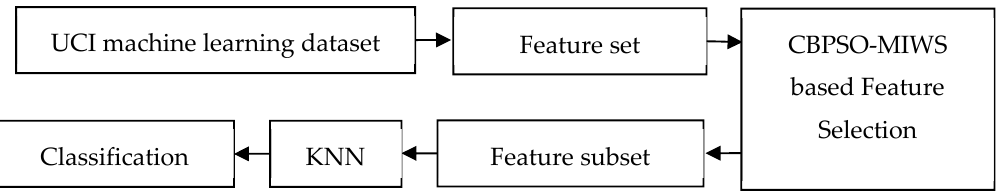
Figure 3. Overview of proposed CBPSO ‐ MIWS for feature selection and classification.